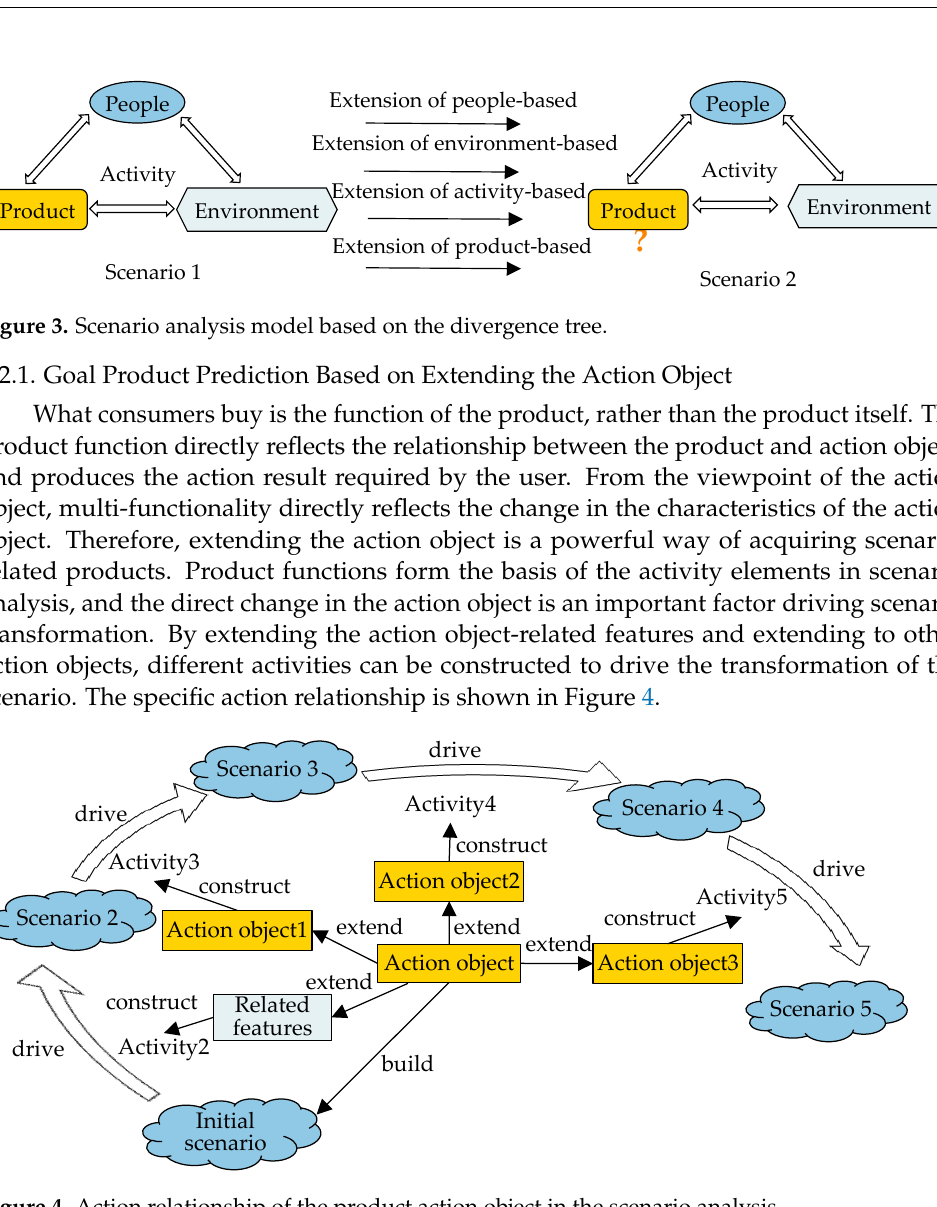
Figure 4. Action relation of the product action object in the scenario analysis.